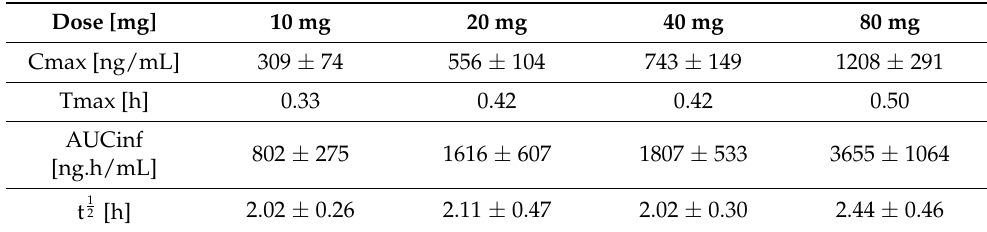
Table 1. Pharmacokinetics from plasma of healthy male subjects after single oral doses (varying dosage) of